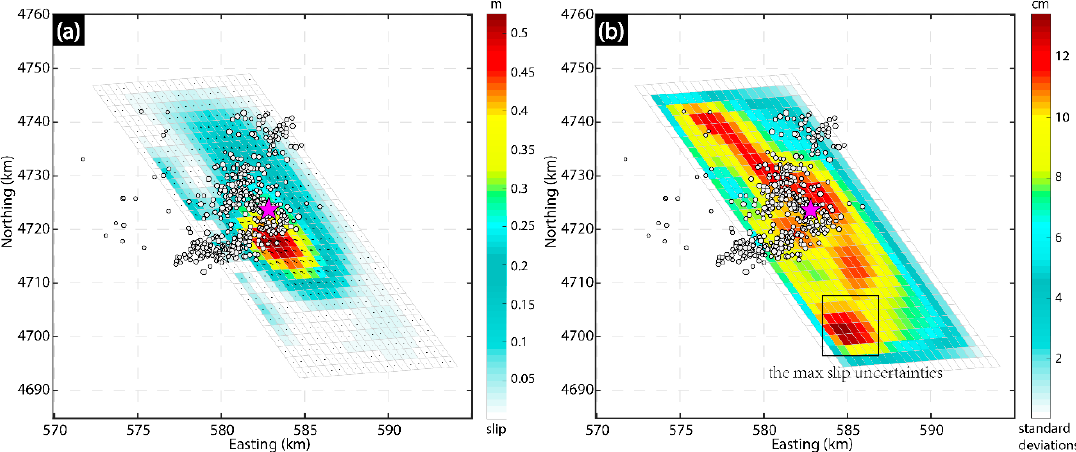
Figure 6. ( a ) Surface projection of the coseismic slip distribution for the 2018 Iburi earthquake. ( b ) Standard deviations of the slip from the Monte Carlo estimation with perturbed datasets. The magenta star denotes the epicenter of the main shock. Gray dots denote the relocated aftershocks within ~2 days from Katsumata et al. [2].